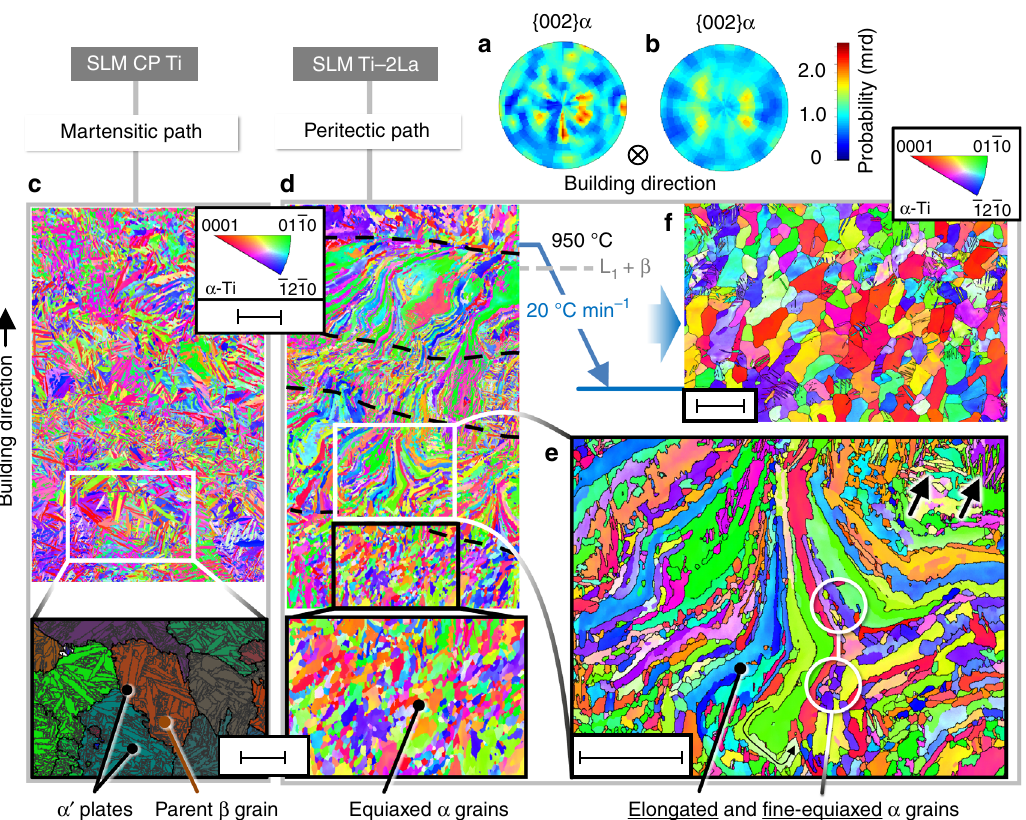
Fig. 2 Texture modi fi cation during selective laser melting (SLM) of Ti-2wt.% La (Ti-2La). The addition of 2wt.% La to commercially pure titanium grade 1 (CP Ti) leads to an attenuation of the preferential orientation of α phase along the building direction as shown in a , b : normalized pole fi gures of {002} α reconstructed from a gauge volume of 1 × 1 × 5 mm 3 for CP Ti and Ti-2La, respectively. c The martensitic microstructure of CP Ti consists of α ′ plates extending within parent β grains according to the Burgers OR. Texture attenuation occurs as a consequence of arrangements of small equiaxed α grains with multiple orientations, nucleated in Ti-2La as shown in d and e (e.g., see encircled grains). f Post- thermal treatment of the SLM as-built condition via slow cooling with 20 °C min − 1 from 950 °C passing through the peritectic line (i.e., from L 1 + β fi eld down to room temperature) provokes the formation of new α grains and extensive globularization, leading to a recrystallized-like microstructure. Black lines in e , f indicate high-angle grain boundaries (misorientation >10°). The scale bars in c , d and in its magni fi ed regions (at the bottom) are 100 μ m and 50 μ m, respectively; in e and f , 50 μ appear at 875 °C from the melt (L 1 ) as shown in the raw diffraction image of Fig. 4c. According to the phase quanti fi cation of HEXRD spectra (Fig. 4a), the peritectic reaction L 1 + β → La- bcc starts after about 50% completion of the β → α transformation.